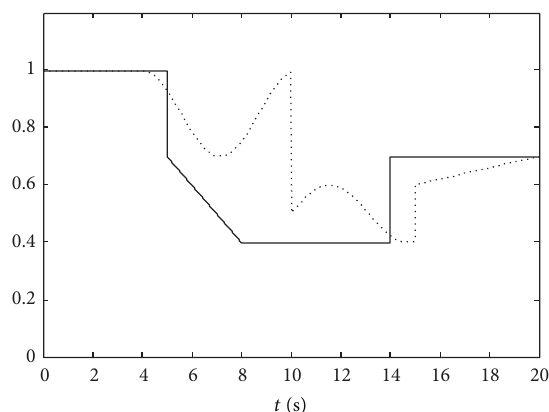
Figure 1: Profile of the time-varying actuator efficiency variable ( 𝛿 1 (solid), 𝛿 2